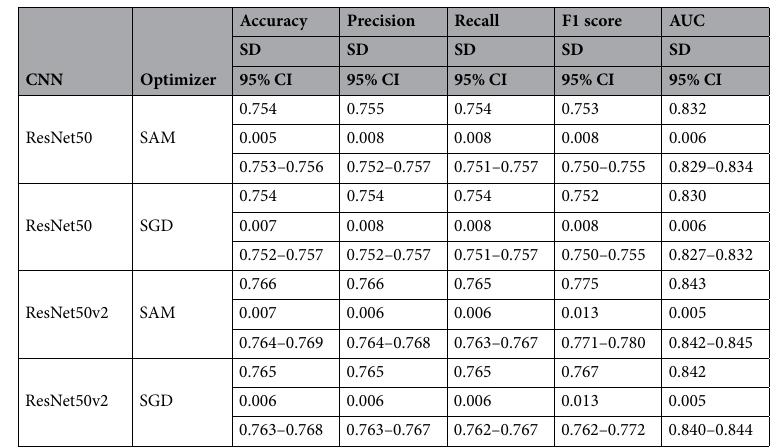
Table 2. Performance metrics of ResNet50 and ResNet50v2 with optimizers SAM and SGD continuity analysis. SD, standard deviation; 95% CI, 95% confidence interval; AUC, area under the receiver operating characteristics curve.